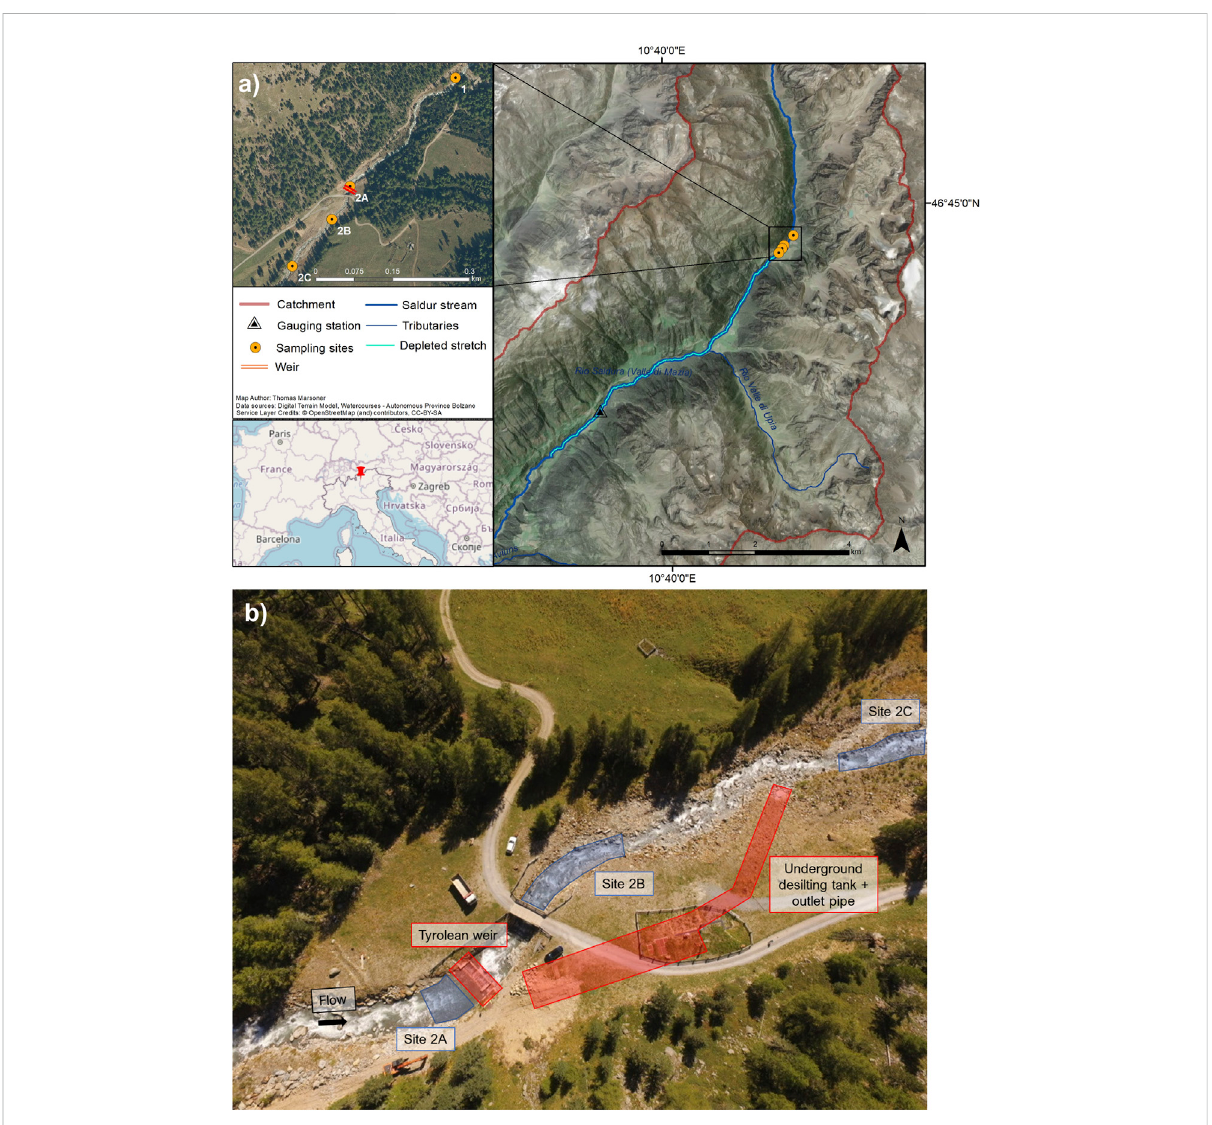
FIGURE 1 (A) Locationof theSaldur stream and ofthesampling sitesalong thelongitudinal stream transect; (B) aerial view ofthesampling sites(blue)and technical infrastructures (red) of the run-of-river hydropower